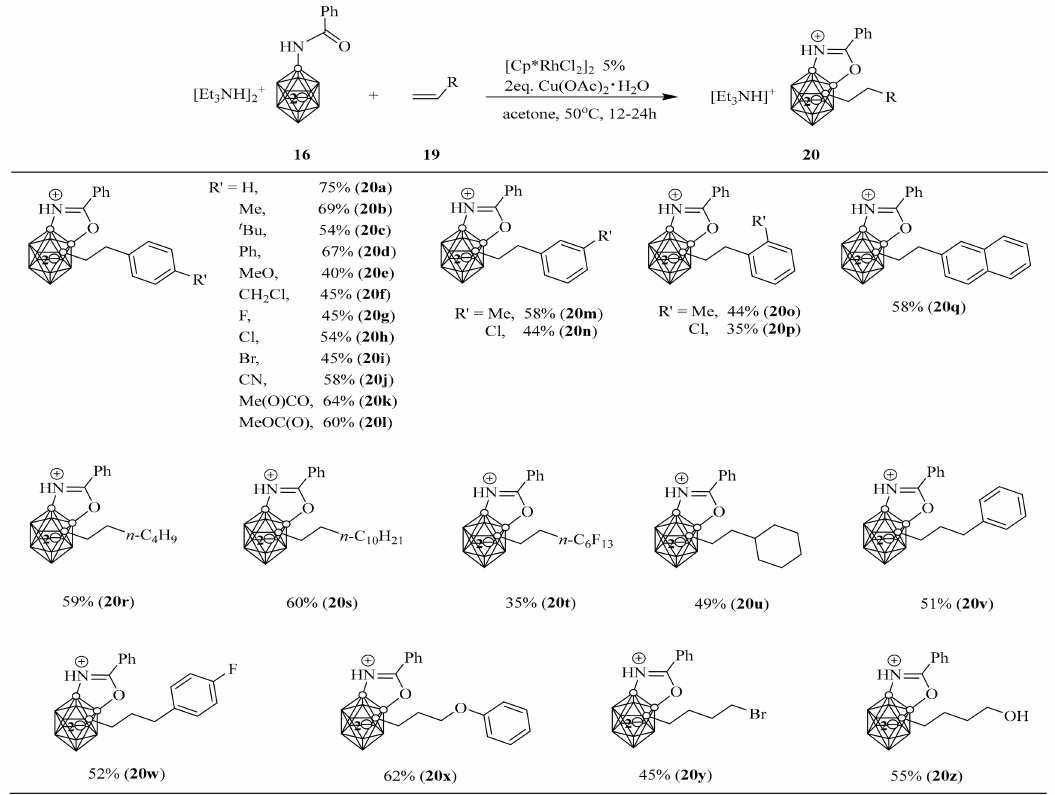
Figure 7. Synthesis of alkyl-substituted dodecaborate-fused